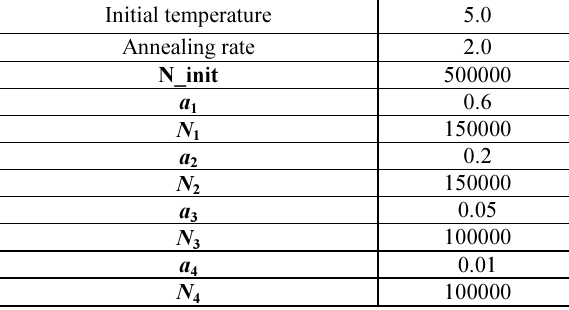
Table 9. SA parameters (55 piles)